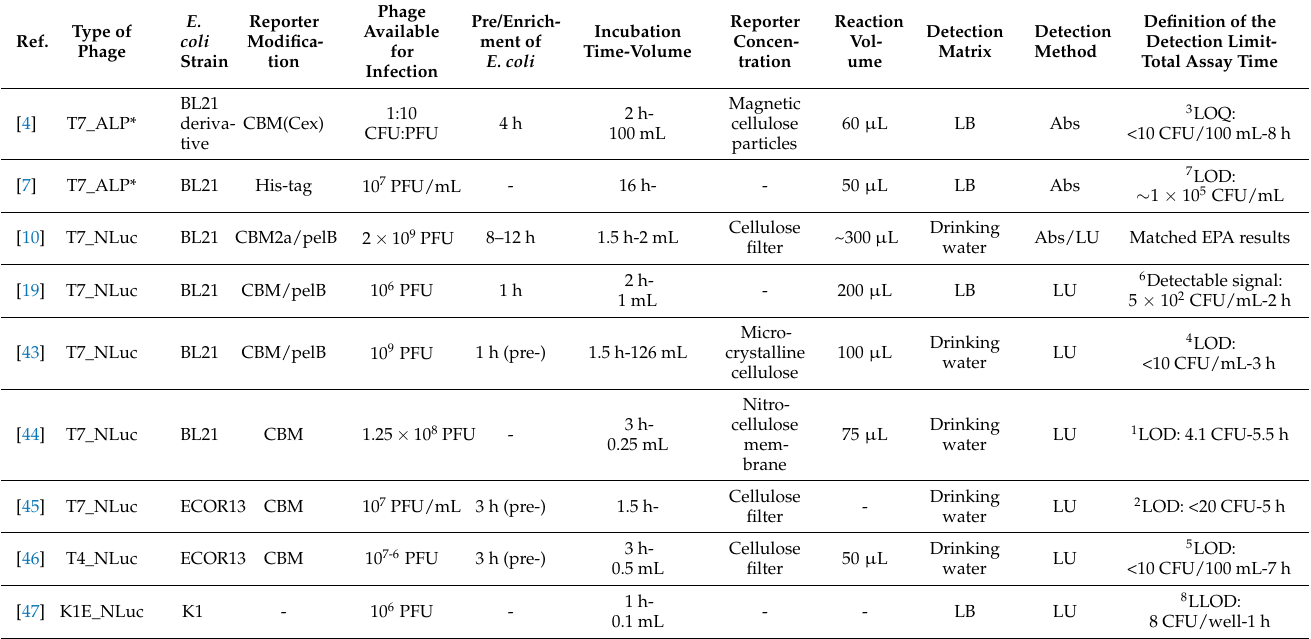
Table 2. Summary of Selected NLuc and ALP* Reporter phage-based detection